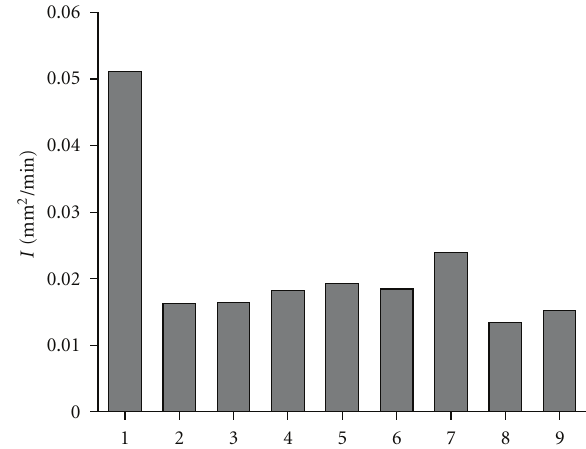
Figure 2: Wear intensity ( I ) of specimens: pure UHMWPE (1), nanocomposites UHMWPE +0.1 (2), 0.5 (3), 1 (4), 2 (5)wt.% HA and microcomposites UHMWPE +5 (6), 10 (7), 20 (8), 40 (9)wt.% HA at the steady-state wearing stage.